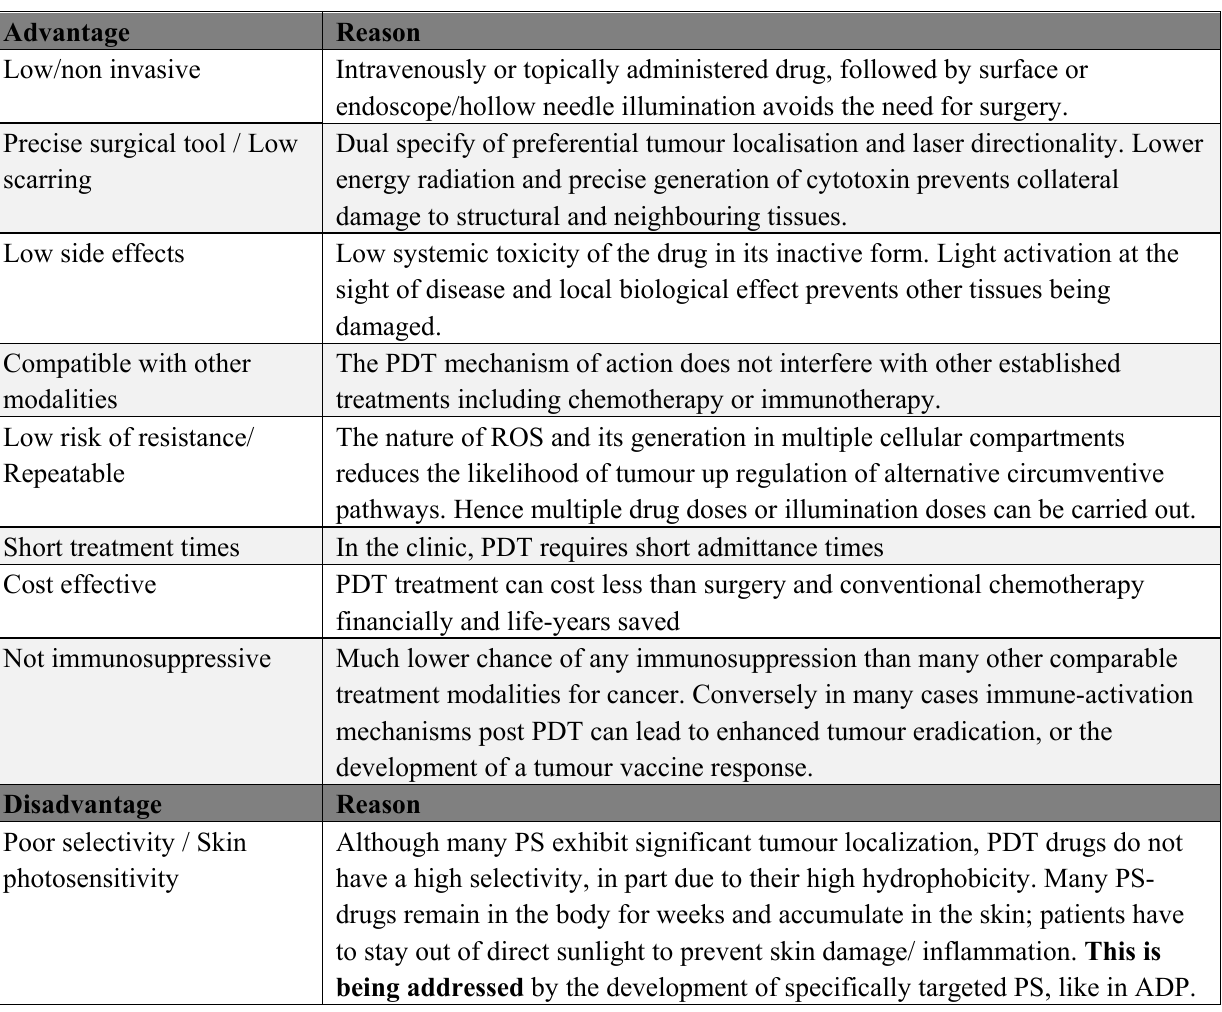
Table 2. Advantages and disadvantages of PDT